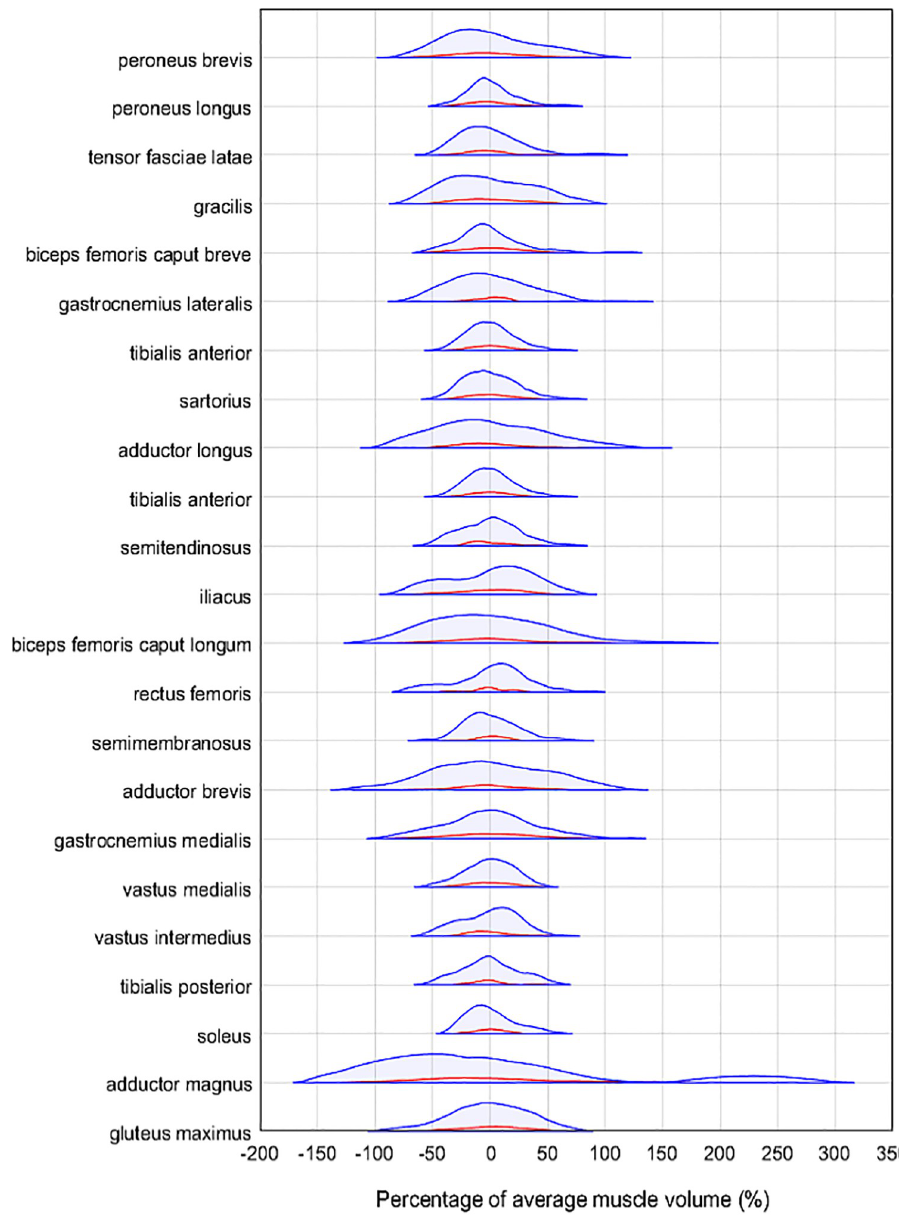
Fig 7. Enhancement of muscle volume variability through image augmentation. The anatomical variability of muscle volumes for each muscle, ordered from smallest to largest within the original and augmented databases shown in red and blue respectively. The height of the distributions was not normalised, and the violin plot contains 95% of the data, with 2.5% of data cut off from each side, removing outliers.